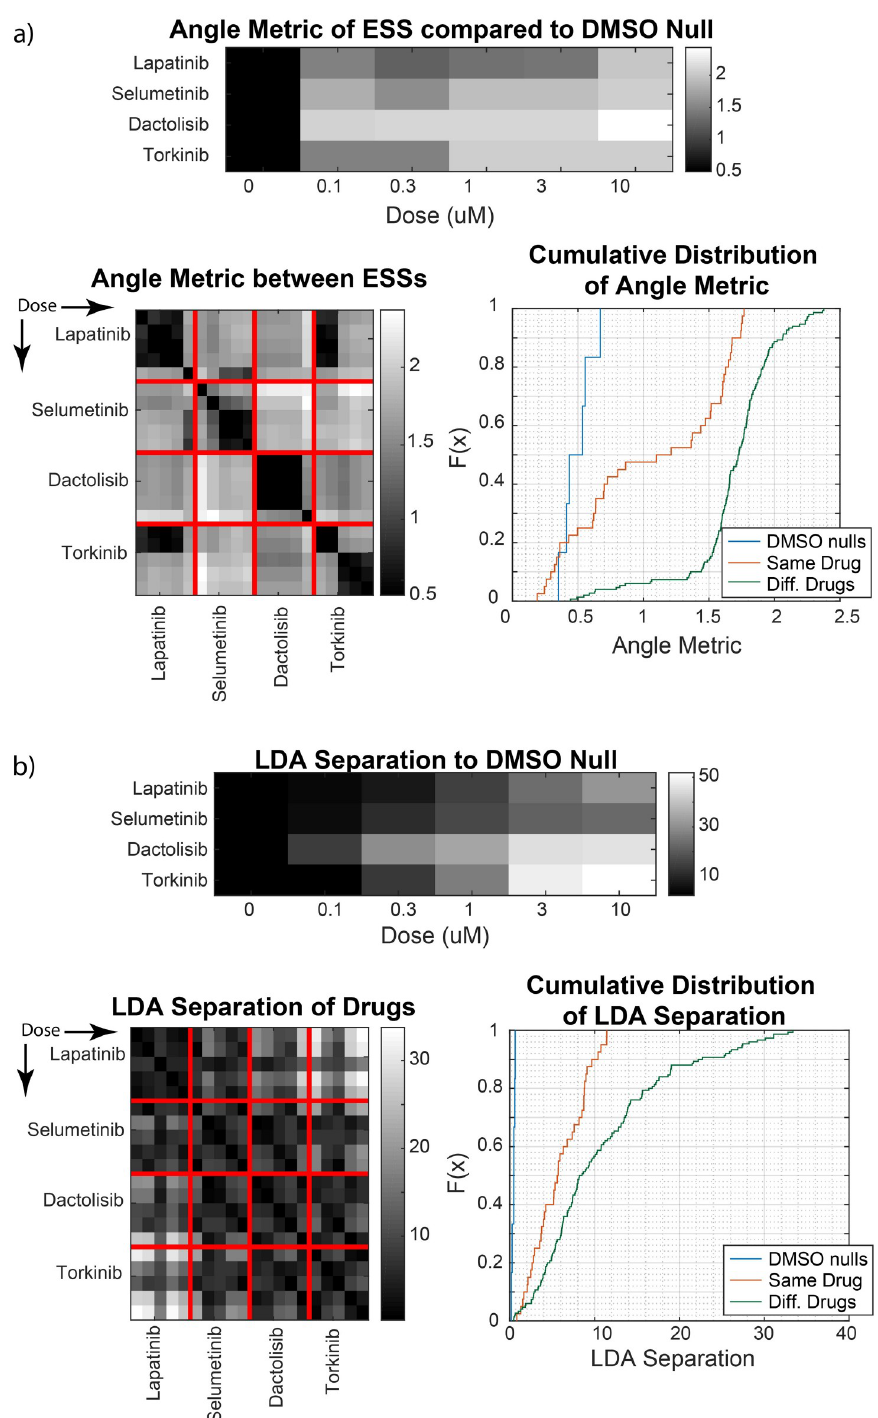
Fig 6. Comparison of reaction networks between drug conditions. (a) Analyses of the ESS between conditions, as quantified by an angle-based metric for a common cutoff of a 10-dimensional ESS. Average metric between a drug condition and the four DMSO replicates (top) are plotted, as well as between any pair of non-zero doses of drug (bottom), arranged by increasing dose. The cumulative distribution of the metric is shown for the pairs between DMSO null replicates, the pairs that used the same drug, and the pairs that used different drugs. (b) Analyses of the LDA separation between the high-dimensional marker distributions, with analogous comparisons as above.